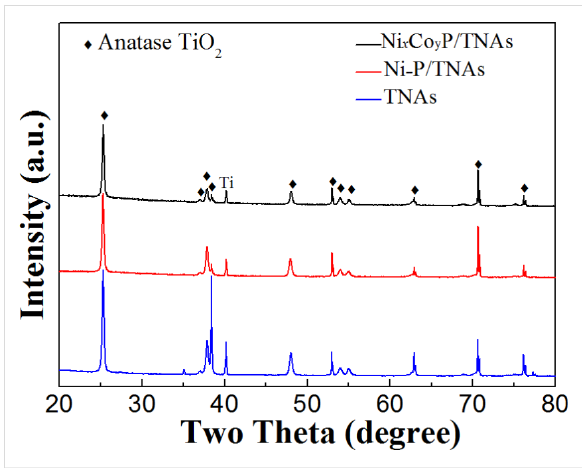
Figure 1: XRD patterns of the